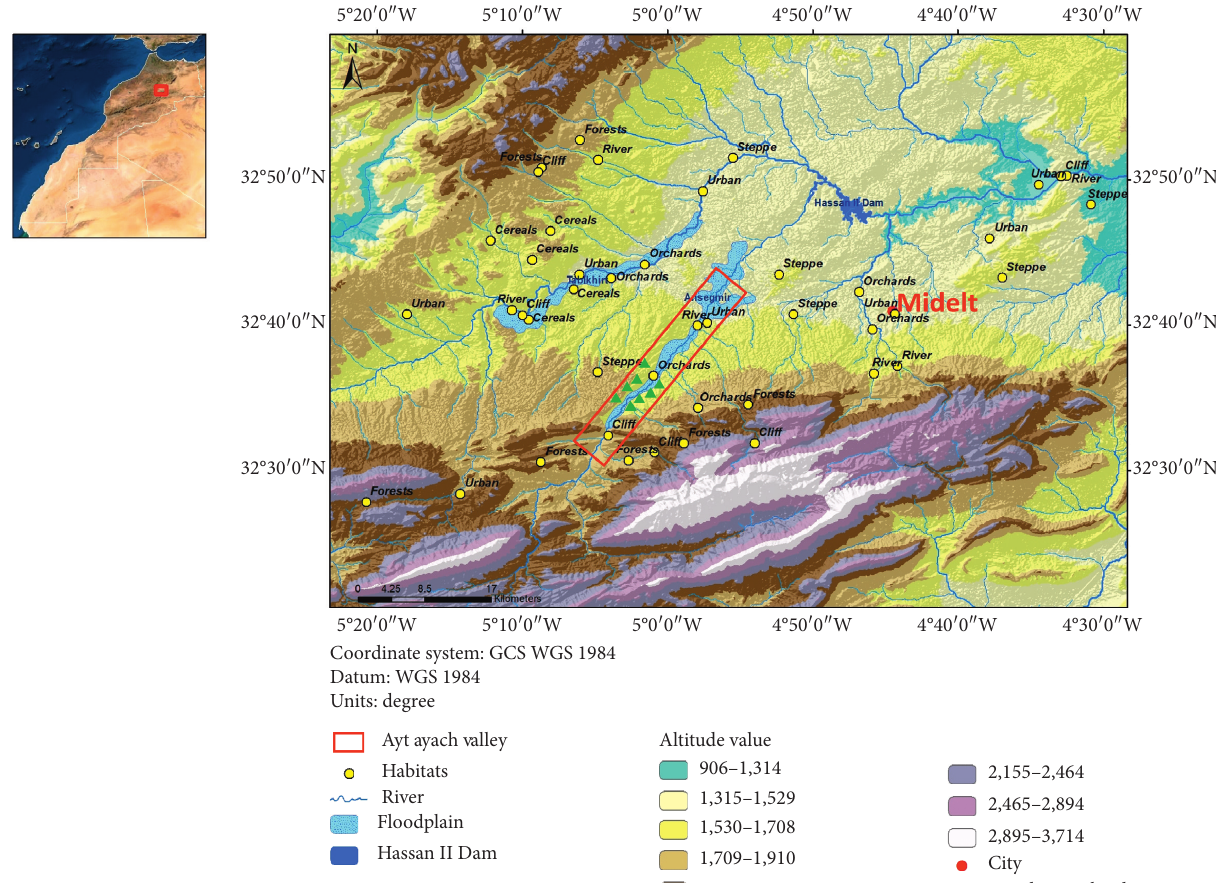
Figure 1: Studied orchards in Ait Ayach valley, Midelt province, Morocco, between 2015 and